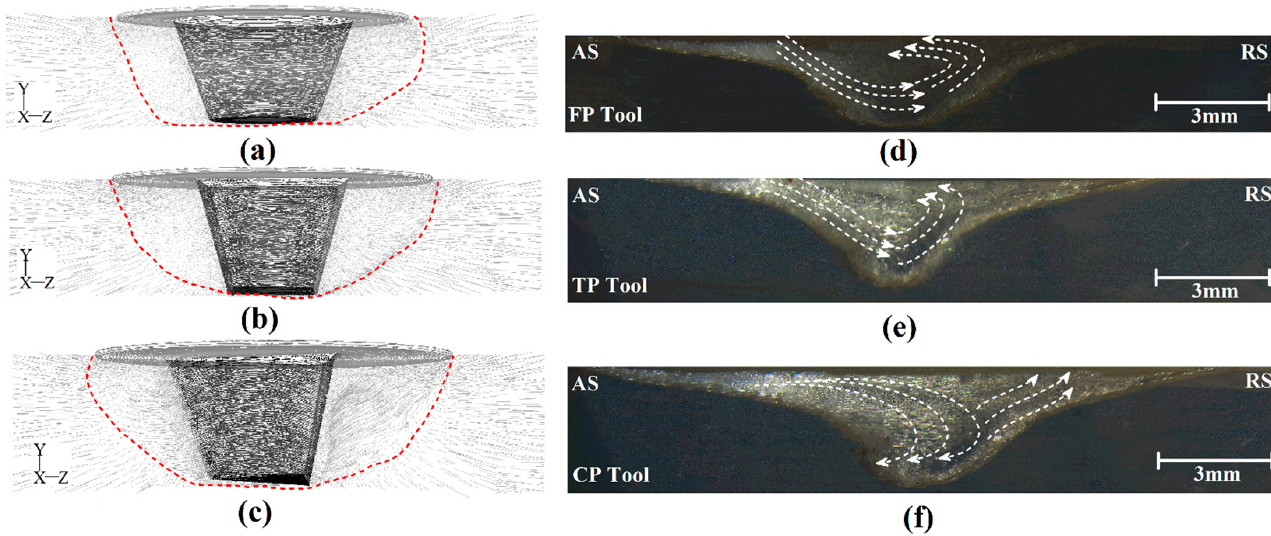
Figure 10. Internal material flow around ( a ) FPT, ( b ) TPT, and ( c ) CPT pins. Internal flow path of joints welded by ( d ) FPT, ( e ) TPT, and ( f ) CPT pins.